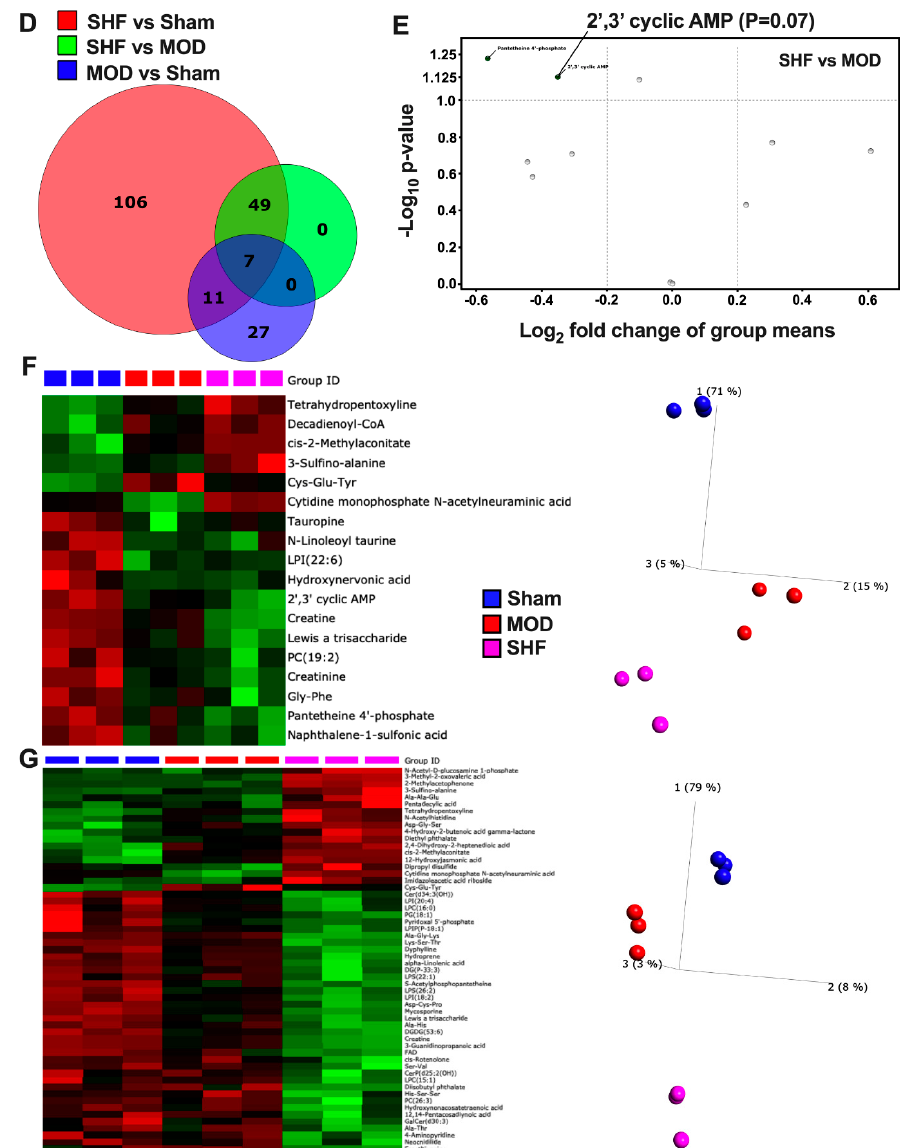
Figure 4. Visualization of the non-targeted metabolomics dataset in Sham, MOD, and SHF groups. ( A ) Heat maps showing differential change in log 2 fold expression of metabolites that changed in MOD vs. Sham (left), and in SHF vs. Sham (right); n = 3 samples per group. ( B ) Volcano plots showing the log 2 fold change in group means, on the x -axis, and the corresponding -Log 10 ( p -value), on the y -axis, for the metabolites that were downregulated (green) or upregulated (red) in MOD (left) and SHF (right) vs. Sham. A -Log 10 ( p -value) cutoff of 1.3 and higher was considered significant. ( C ) PCA plots showing the variance in biological samples within and between the Sham, MOD, and SHF groups for the metabolites that changed in MOD (left) and SHF (right) vs. Sham. ( D ) Venn diagram showing the number of metabolites that changed in SHF (red) and MOD (blue) vs. Sham and those that changed in SHF vs. MOD (green). ( E ) Volcano plot of the 11 common identified metabolites that changed in MOD and SHF vs. Sham (intersection of red and blue diagrams excluding the green diagram). Of those, there was a trend for further downregulation of pantetheine 4 (cid:48) -phosphate and 2 (cid:48) ,3 (cid:48) cyclic AMP in SHF compared with MOD. ( F ) Heat map and PCA plot for the 17 common metabolites that changed in MOD and SHF vs. Sham. ( G ) Heat map and PCA plot for the metabolites that changed in SHF vs. Sham and MOD groups. Heat maps and PCA plots in both F and G show the differential log 2 fold change in expression in Sham, MOD, and SHF groups and the variance in biological samples, respectively, for the metabolites presented in ( F ) and ( G